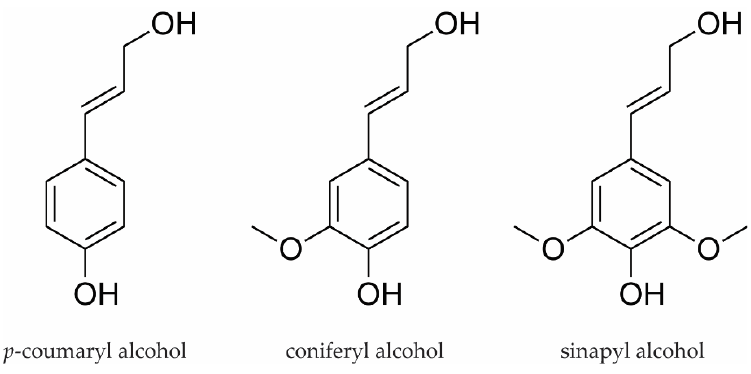
Figure 1. Main building blocks of lignin.